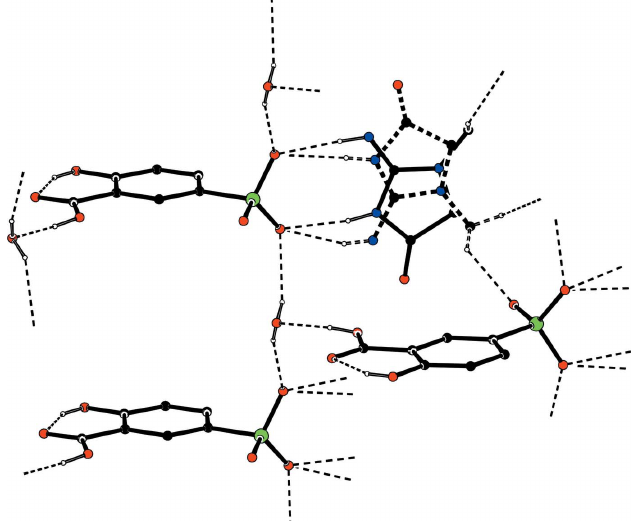
Figure 2 The partial packing of the title molecular salt, showing ring-set motifs. Hydrogen bonds are shown as dashed lines.